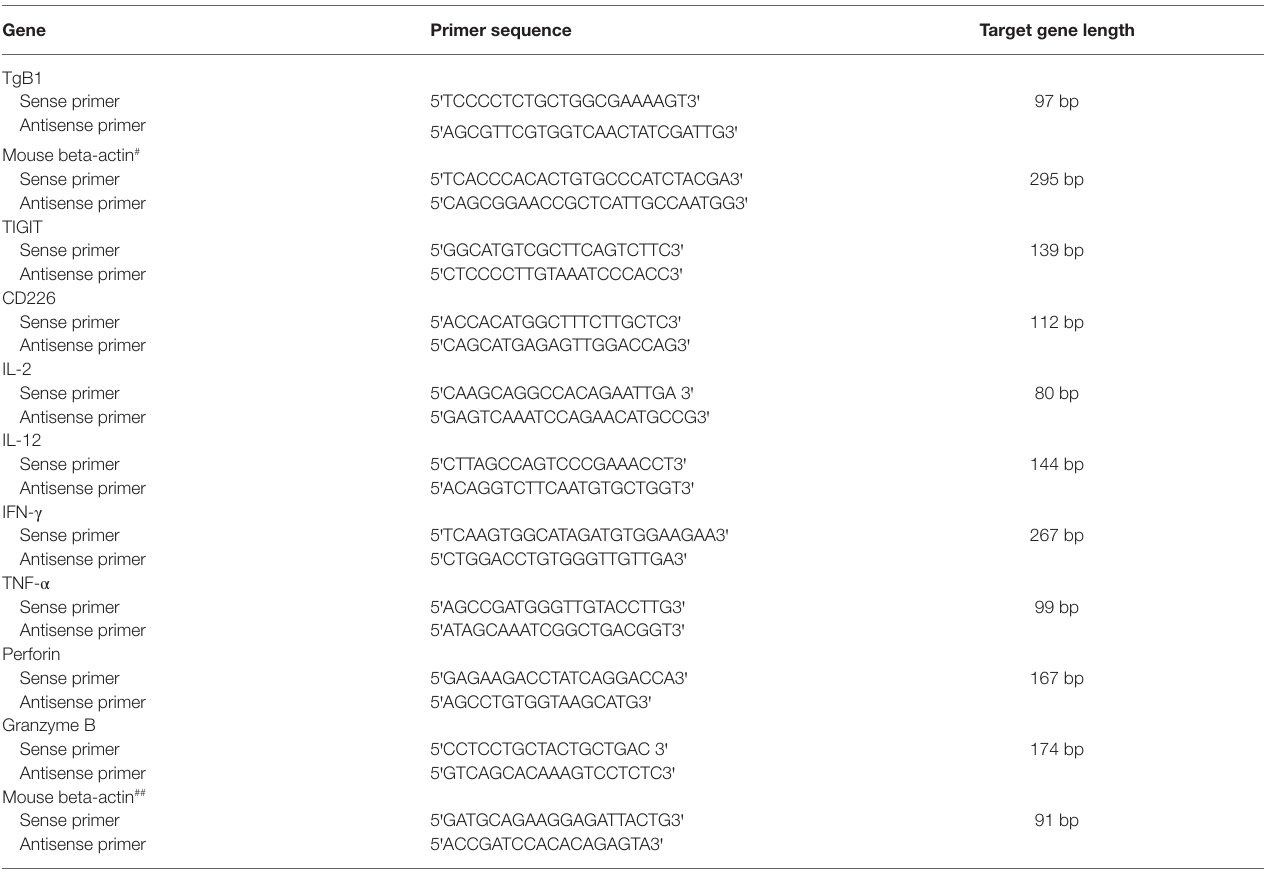
TABLE 1 | Sequences of the primers used in this